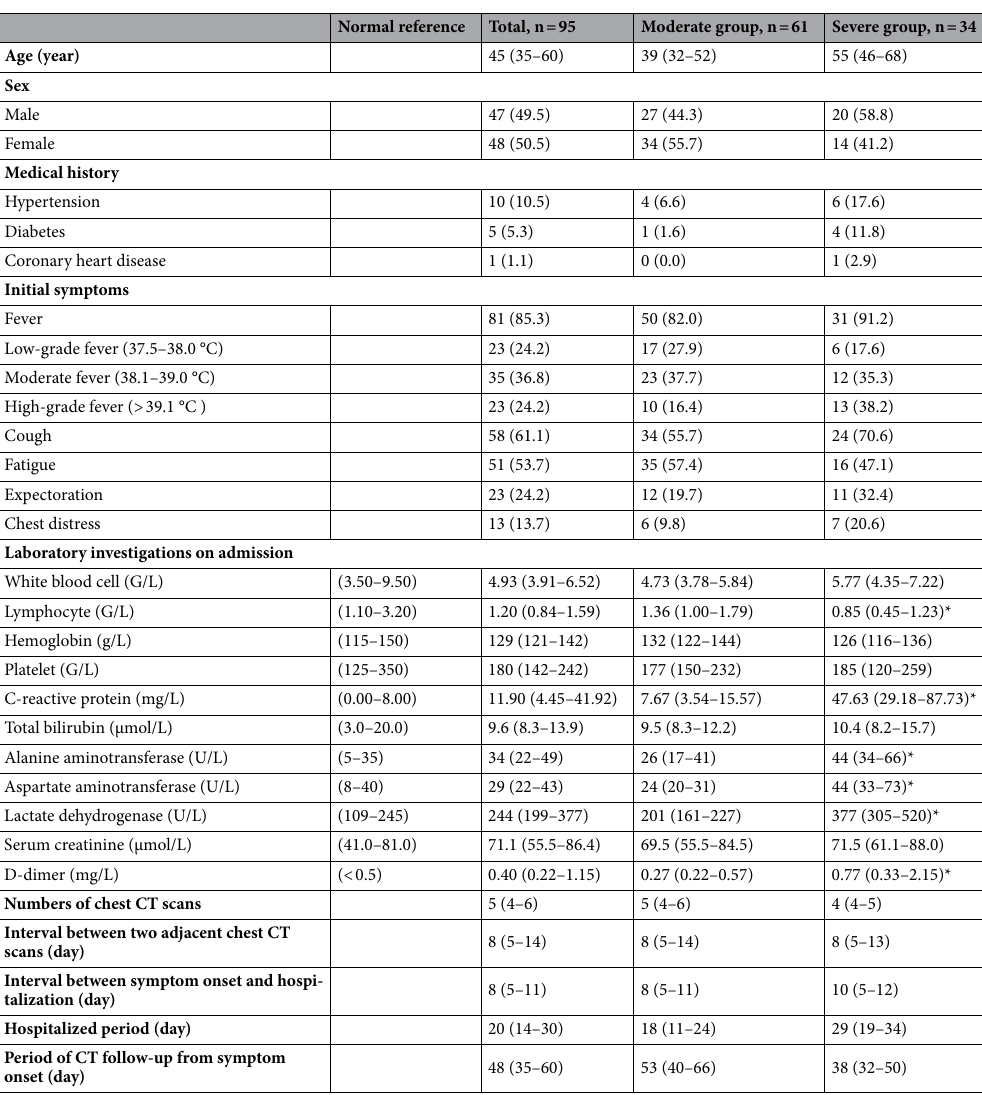
Table 1. Basic characteristics and clinical outcomes. The comparisons of the quantitative and counting data between moderate and severe groups were statistically evaluated using the Mann–Whitney U test and Chi- square test, respectively, and the statistical difference (p < 0.05) between the two groups was noted ( *